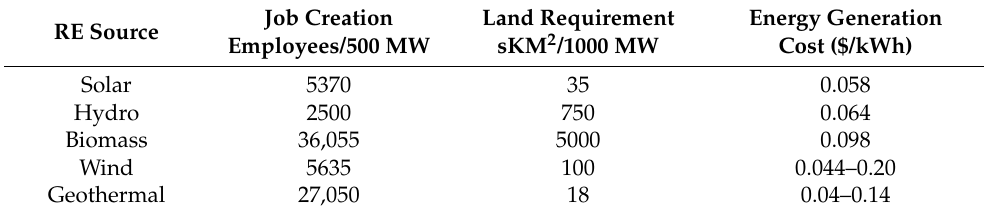
Table 6. Job creation, land requirements, and energy generation cost for RE technologies in USA [78,79].